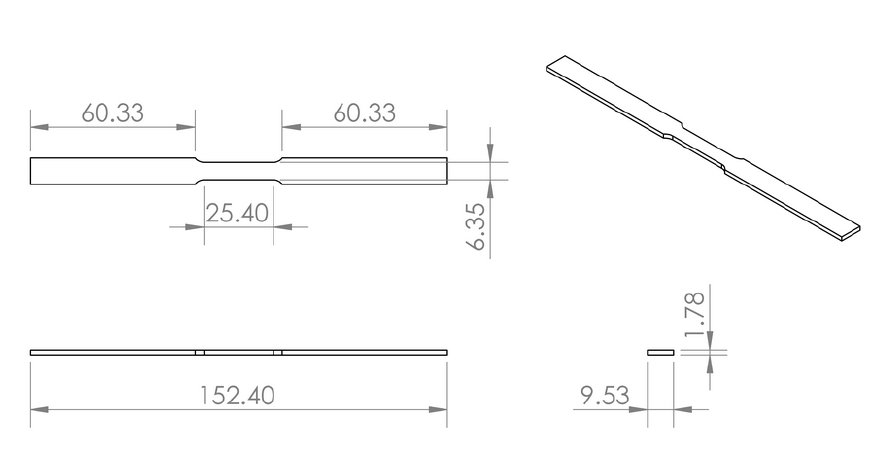
Figure 7. Drawing of coupon used in elevated-temperature testing. All dimensions shown are in mm.